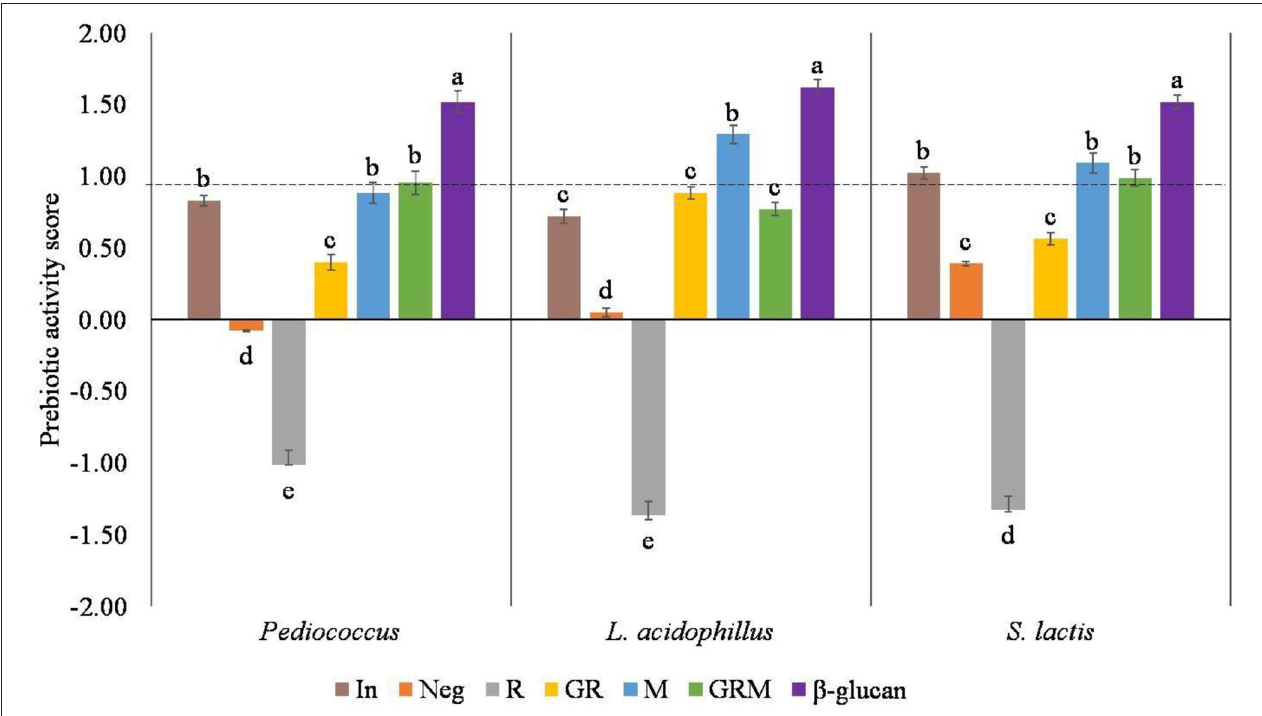
FIGURE 3 | Prebiotic activity score in different samples. In, Neg, R, GR, M, GRM, and β -glucan: inulin, negative control, Riceberry rice, germinated rice, oyster mushroom mycelium, and mushroom, germinated rice berry with oyster mushroom mycelium and β -glucan. Results in the same strain of bacteria with the same superscript were not significantly ( p > 0.05)